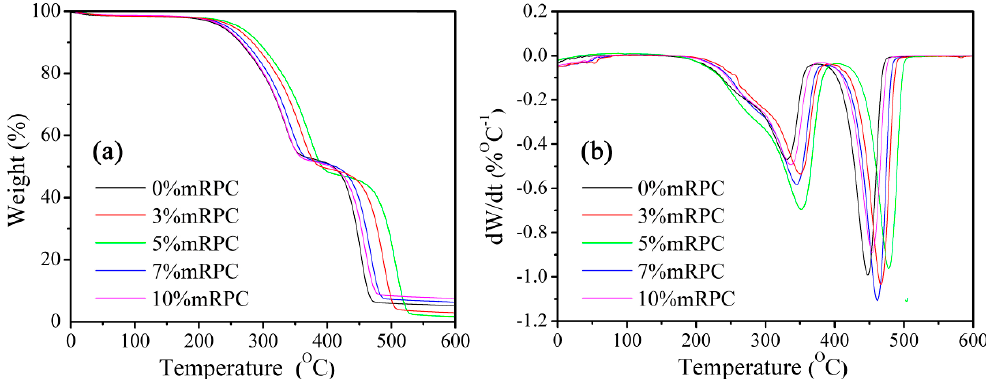
Figure 7. ( a ) TGA and ( b ) DTG curves of the mRPC/HDPE/wood fiber composites.